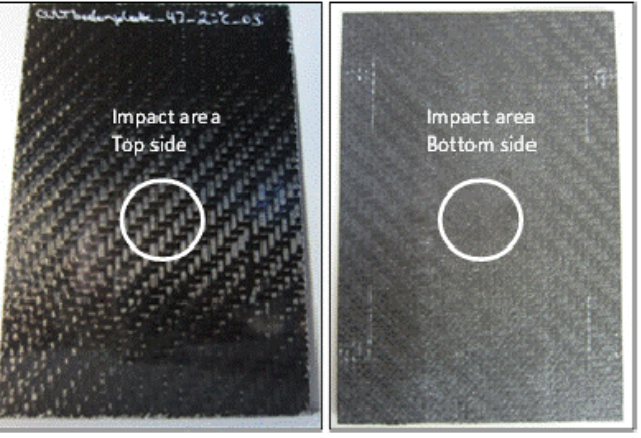
Figure 10. Visual failure detection for an impact energy of 4 J; ( left ) top side up; ( right ) bottom side up.